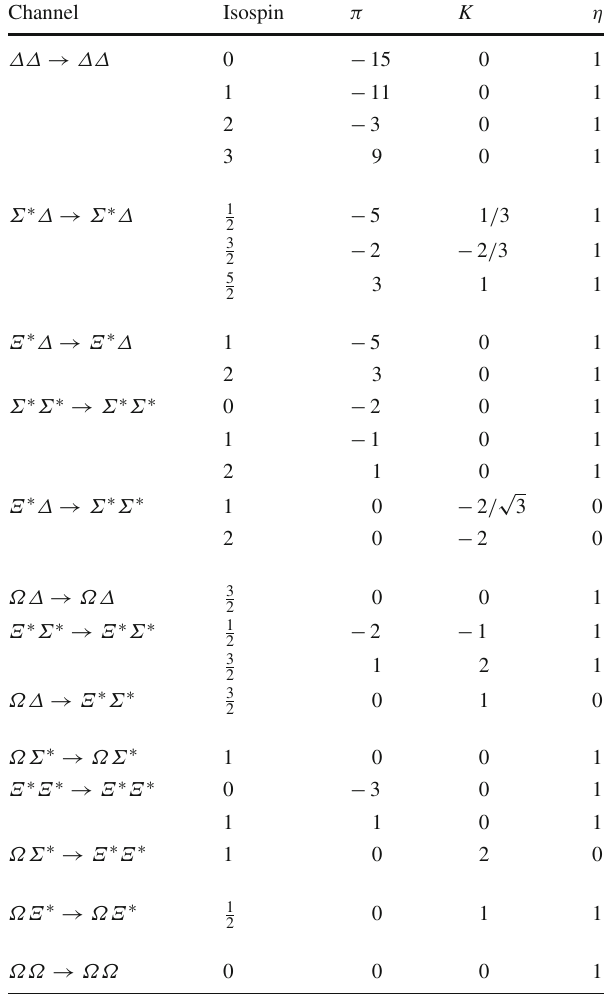
Table 3 Decuplet–decuplet scattering: isospin factors I P for the vari- ous meson exchanges Channel Isospin